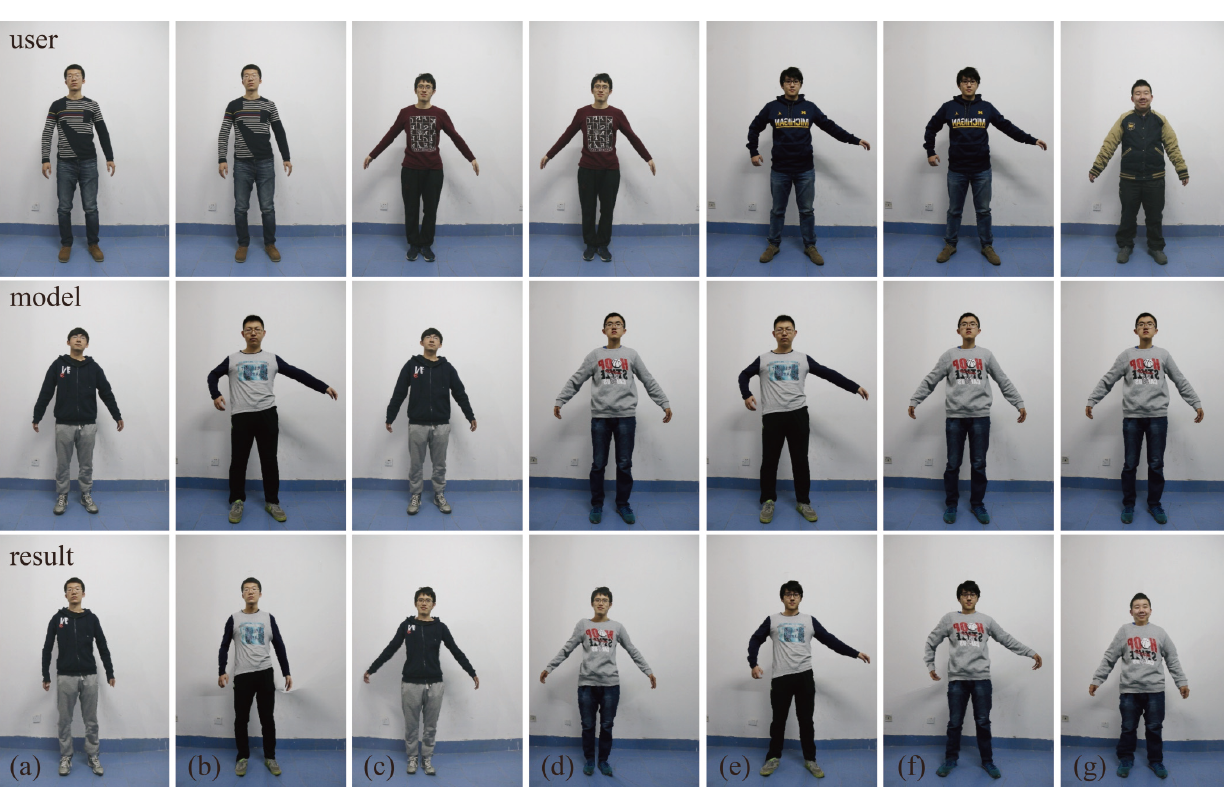
Fig. 9 Results for our